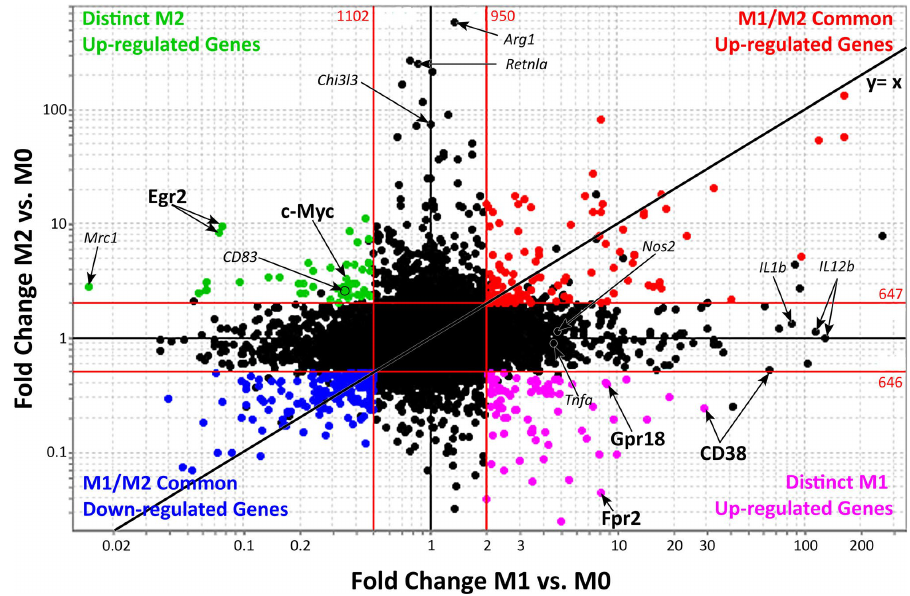
Figure 2. Genes expressed during M1 and M2 macrophages